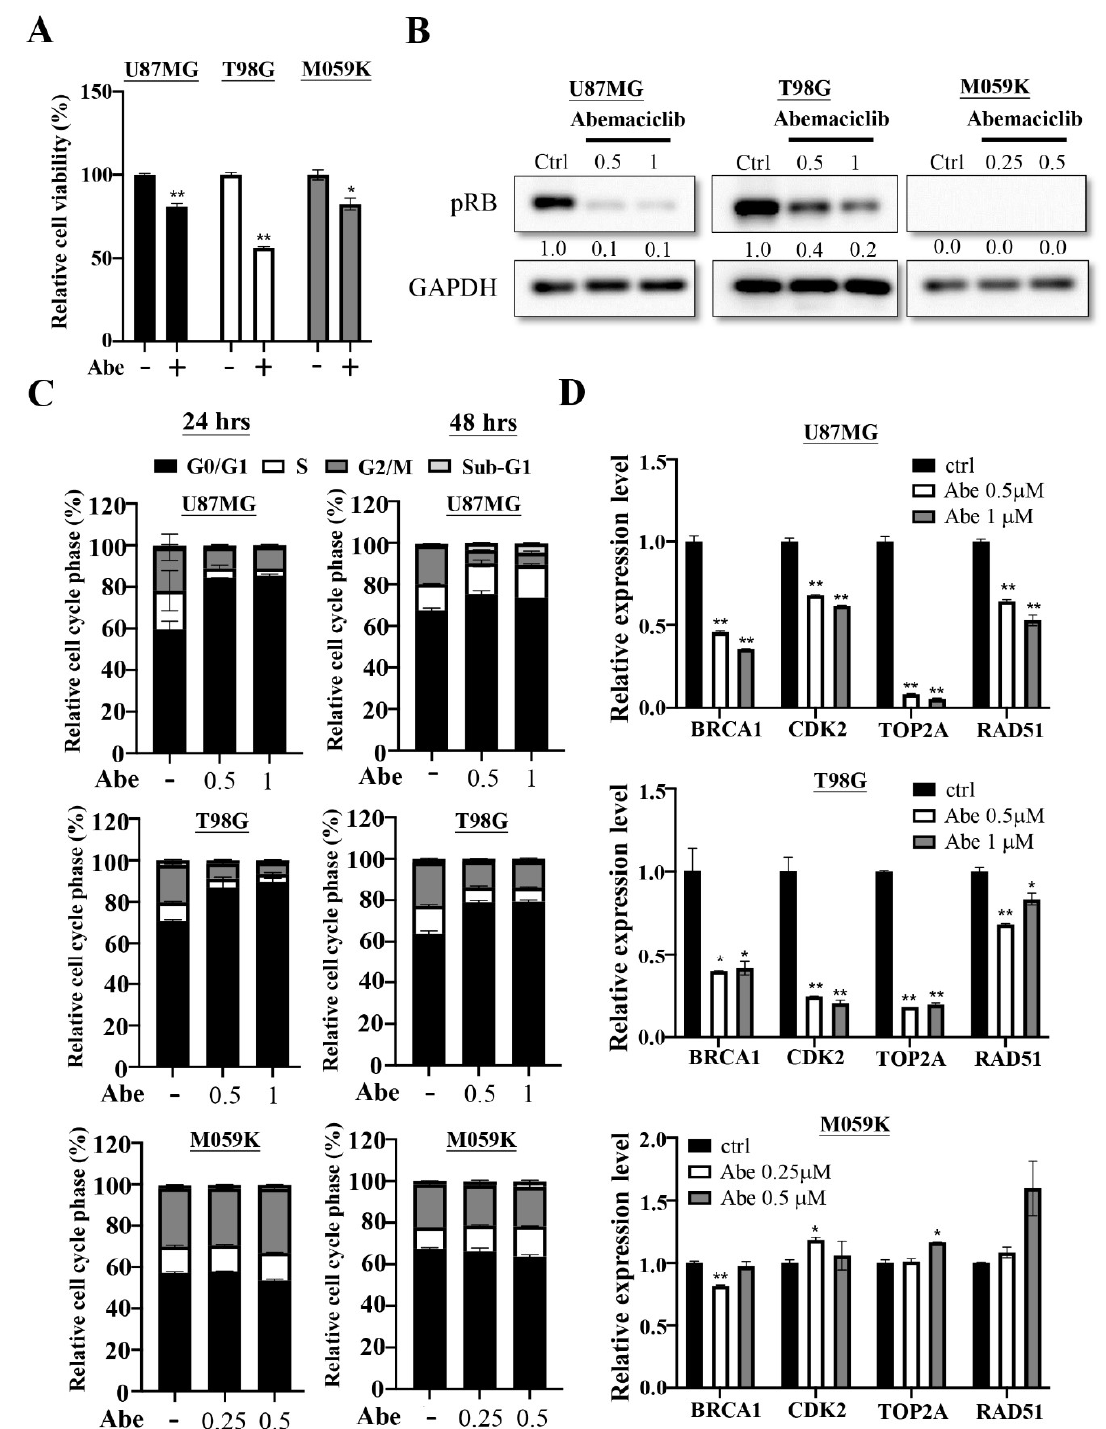
Figure 1. Abemaciclib treatment regulates cell proliferation on the U87MG, T98G and M059K cells. ( A ) The three cancer cells were treated with abemaciclib for 72 h and the proliferation rate was evaluated by using MTT assay. Data are presented as the mean ± SD of duplicate wells, and are representative of two independent experiments. Abe: abemaciclib. (* p < 0.05, ** p < 0.01 compared to control group) ( B ) The three cancer cells were treated with the indicated concentrations (μM) of abemaciclib for 24 h and the levels of phosphorylated RB were detected via Western blot analysis (Figure S1). ( C ) The three cancer cells were exposed to the indicated concentrations (μM) of abemaciclib for 24 and 48 h and then subjected to cell cycle analysis. Data are presented as the mean ± SD (n = 2). ( D ) Expressions of indicated genes in the three cancer cells were validated by qPCR. The results are presented as the mean ± SD for duplicate samples. (* p < 0.05, ** p < 0.01 compared to control group) .